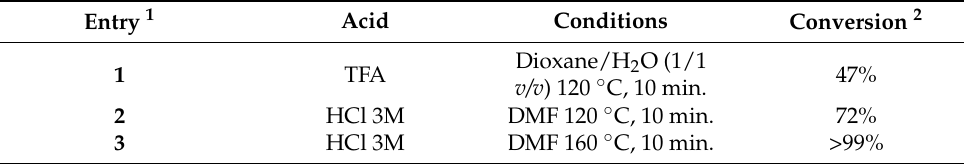
Table 2. Reaction conditions explored for the deprotection of Boc groups on [ 18 F]8 . Entry 1